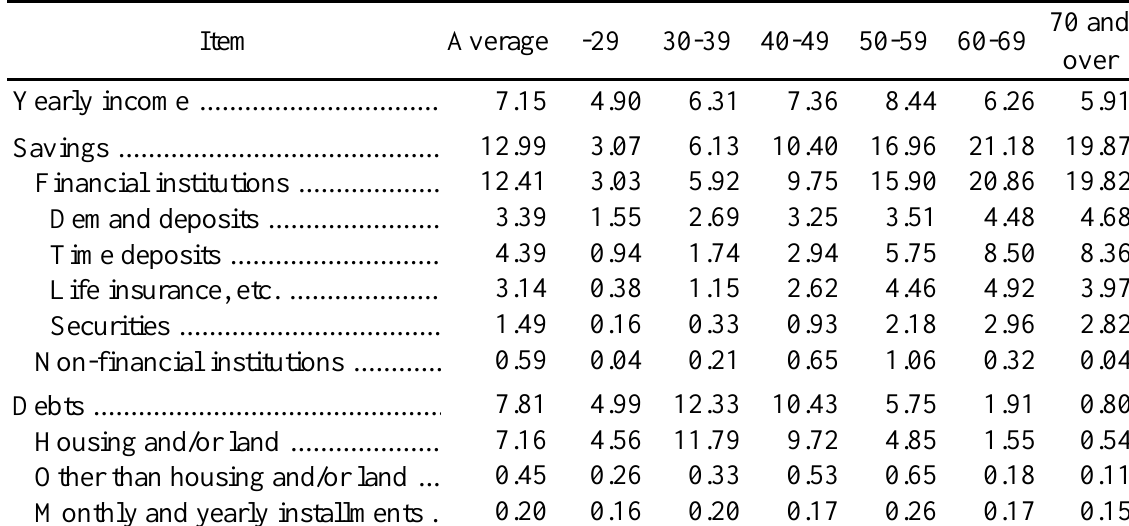
Monthly and yearly installments